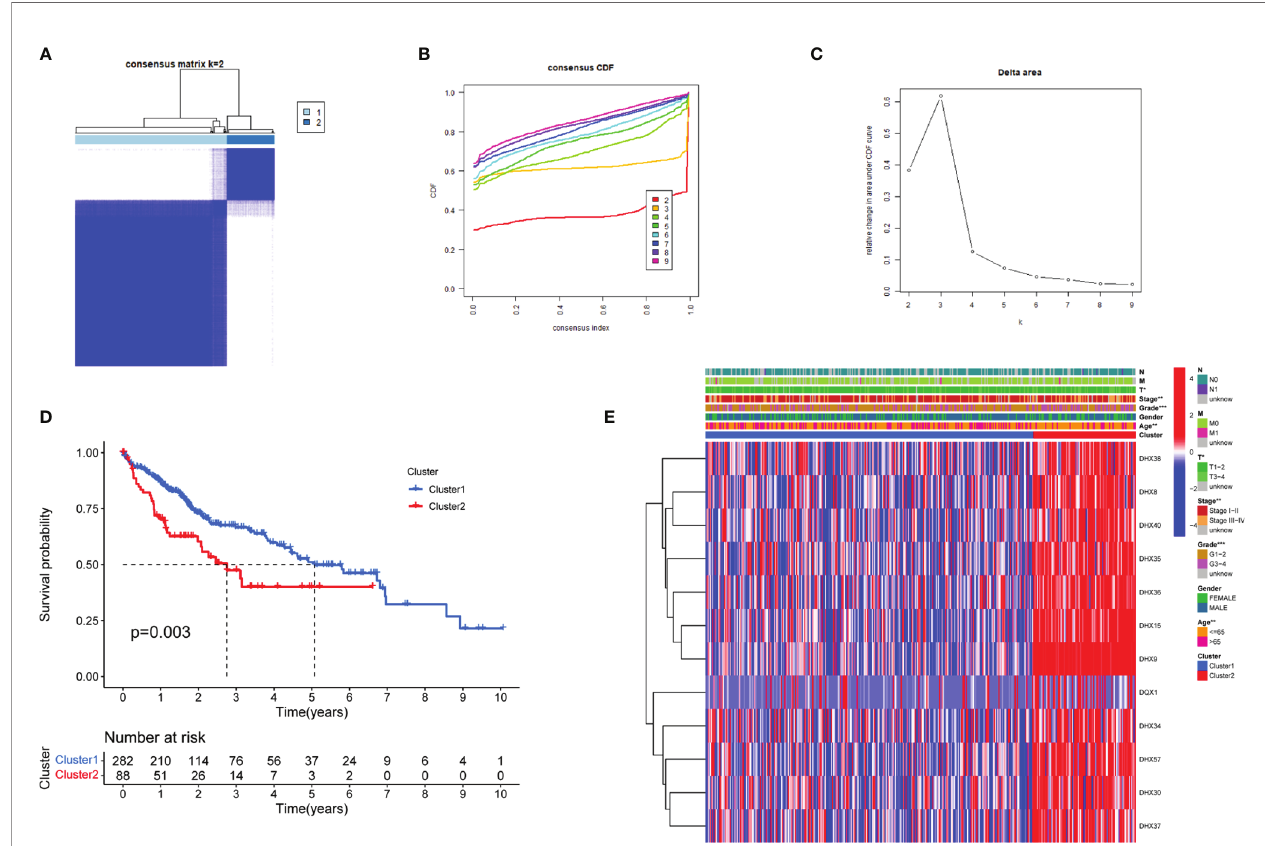
FIGURE 2 | Identi fi cation of LIHC molecular subtypes based on the prognostic DEAH-box RNA helicases. (A) Consensus matrix heatmaps (k = 2) of prognostic genes. (B) Curve of cumulative distribution function (CDF) (k = 2 to 9). (C) The relative variation of the area under the CDF curve (k = 2 to 9). (D) KM curves of overall survival in the two LIHC clusters. (E) Heatmap of the expression of 12 survival-related genes in the different clusters and clinicopathological characteristics of the two subtypes. * p < 0.05; ** p < 0.01; and *** p <